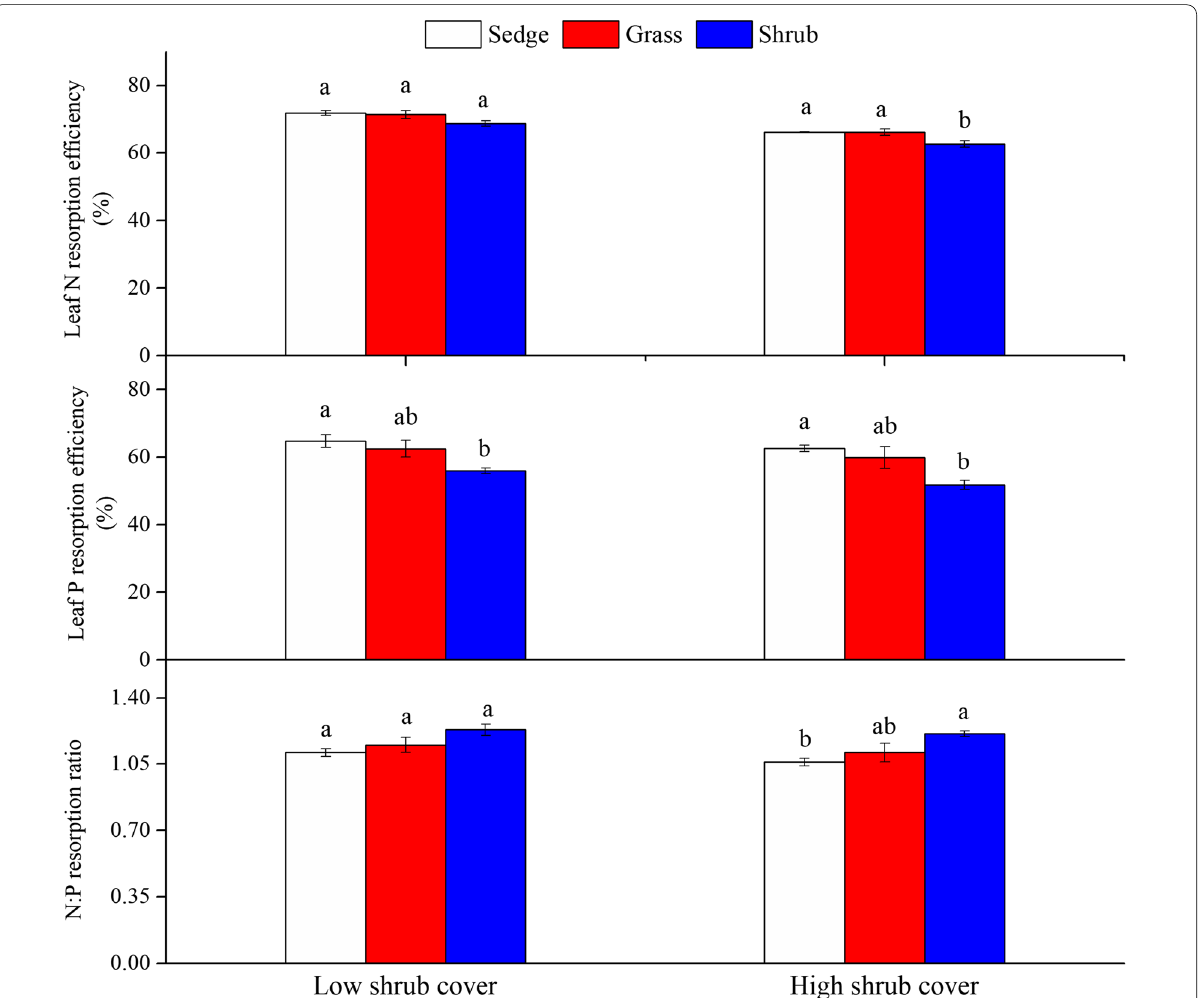
Fig. 2 Effect of shrub encroachment on leaf nutrient resorption efficiency at the plant growth form level in freshwater wetlands of Northeast China. Error bars are the standard errors of the mean ( n 3). Different lowercase letters indicate the significant difference ( P < 0.05) among plant growth = forms within each wetland